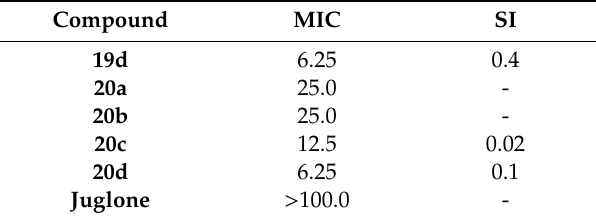
Table 4. Minimum inhibitory concentration (MIC, µ M) and selectivity index (SI) of testing compounds against S. aureus